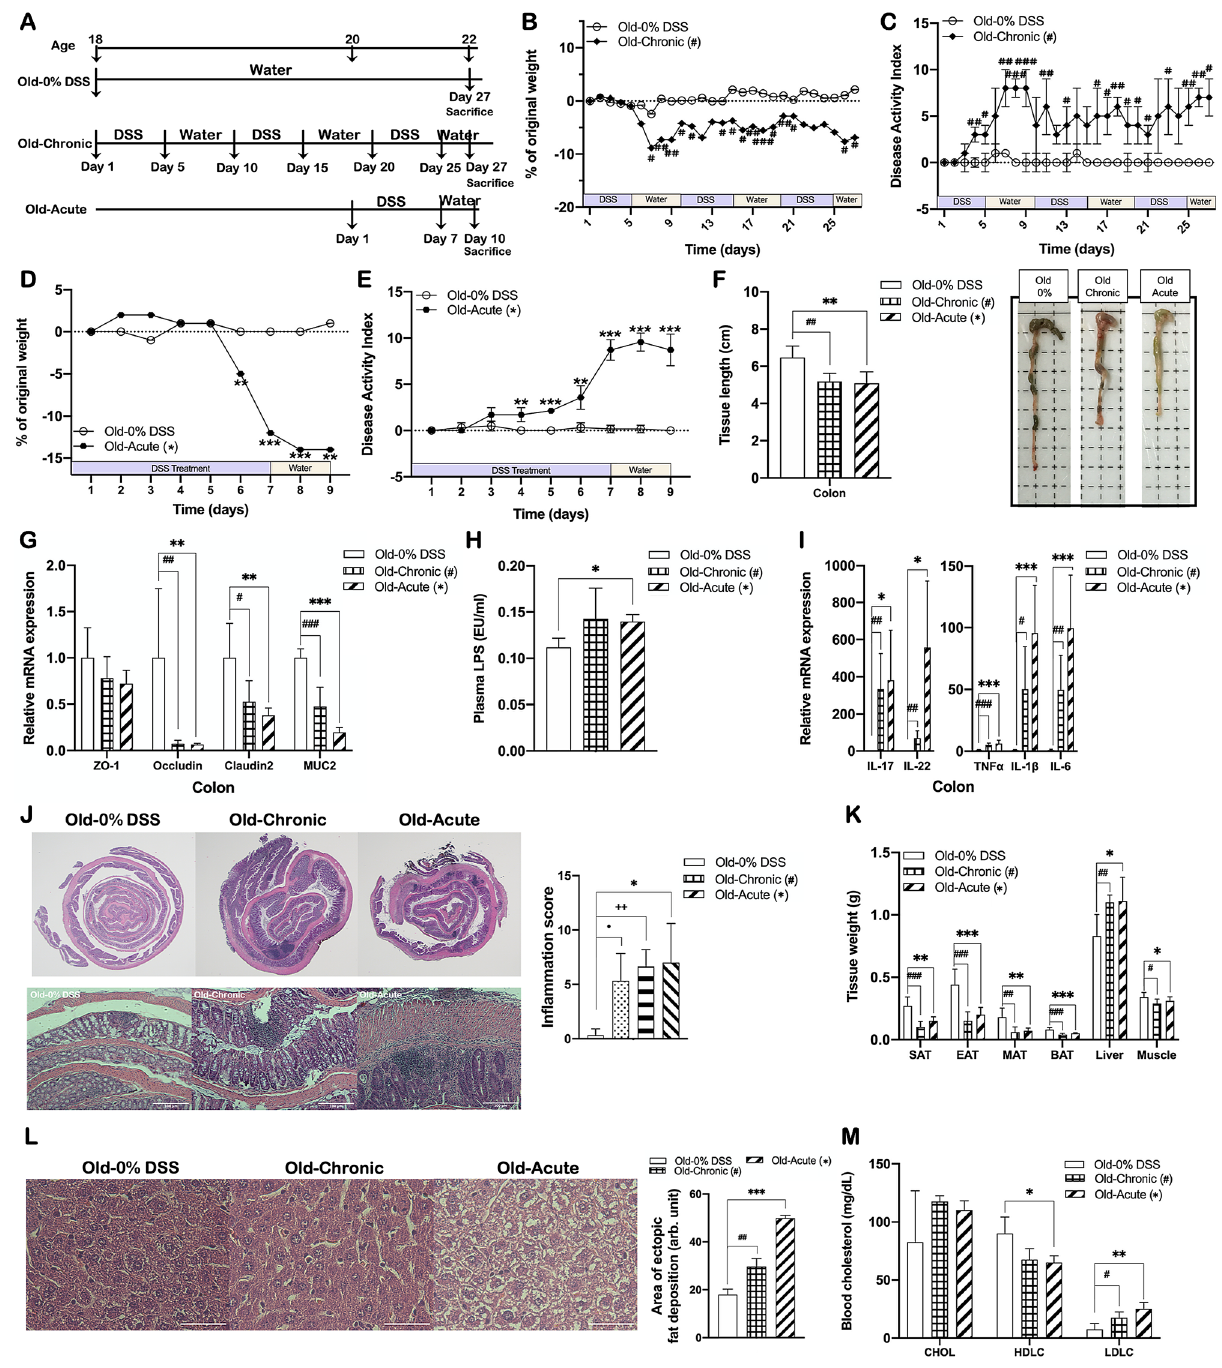
Figure 6. DSS-induced colitis-associated hepatic steatosis and dyslipidemia are displayed also in older mice. ( A ) Experimental scheme illustrating the cycles of DSS and water treatment. Changes in ( B , D ) body weight and ( C , E ) DAI during chronic and acute DSS treatment, respectively. ( F ) Colon length and representative photographs for colon tissue of DSS-treated and non-treated mice. Colonic expression of ( G ) tight junction proteins and mucin, and ( I ) inflammatory cytokines in DSS-treated and non-treated mice. Gene expression levels are normalized to GAPDH expression. ( J ) Representative images of H&E staining of Swiss roll section of colon segment (left; ×12.5) and colon tissue (center; ×200; scale bar, 100 μm), and a graph representing inflammation score (right). ( K ) Tissue weights of DSS- induced colitis and non-colitis mice. ( L ) Representative images of H&E staining of liver sections (×400; scale bar, 50 μm) and a graph presenting area of ectopic fat deposition. Plasma levels of (H) LPS, (M) total, HDL- and LDL-cholesterol in DSS-induced colitis and non-colitis mice. Data present mean ± SD for 6–7 mice in each group. Statistical significance was determined using two-way ANOVA with ( B – E ) with Dunnett’s comparison test. #, * p < 0.0332, ##, ** p < 0.0021, ###, *** p < 0.0002. Student’s two-tailed t-test was used for the analysis of differences between experimental groups ( F – M